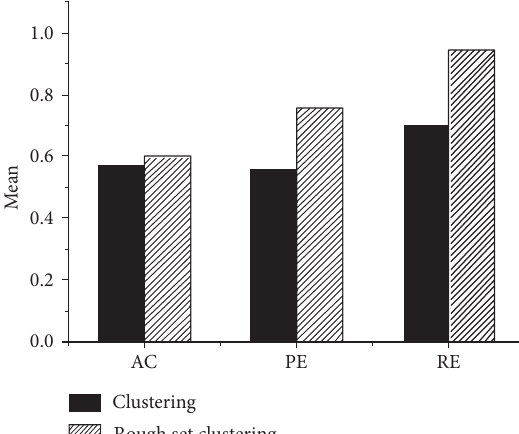
Figure 7: Comparison on performance of clustering algorithm on the Chess data set. Note: AC, PE, and RE in the figure refer to accuracy, precision, and recall, respectively.